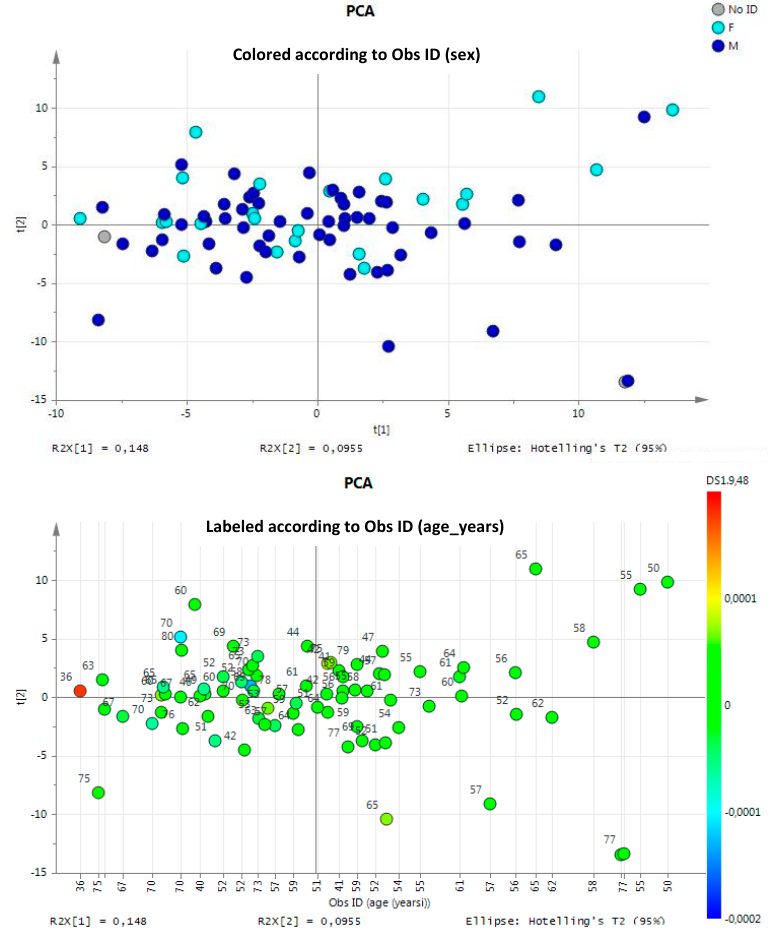
Figure 1. Principal Component Analysis (PCA) applied on all urine samples. It showed no clusters relating to sex (F = female, M = male) or age (years).